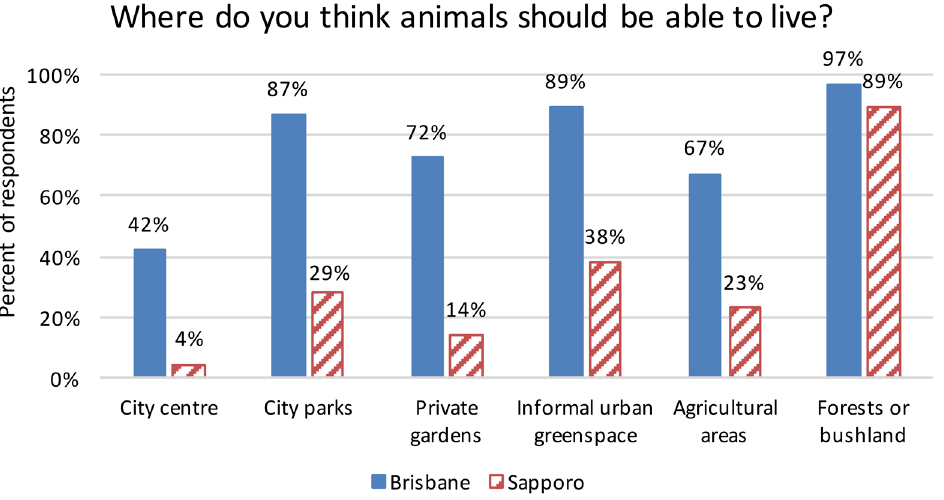
Fig. 3. Brisbane and Sapporo respondents’ perceived places of belonging for animals.